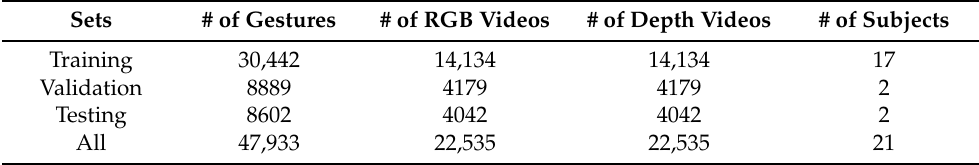
Table 5. Statistics of the ChaLearn LAP ConGD